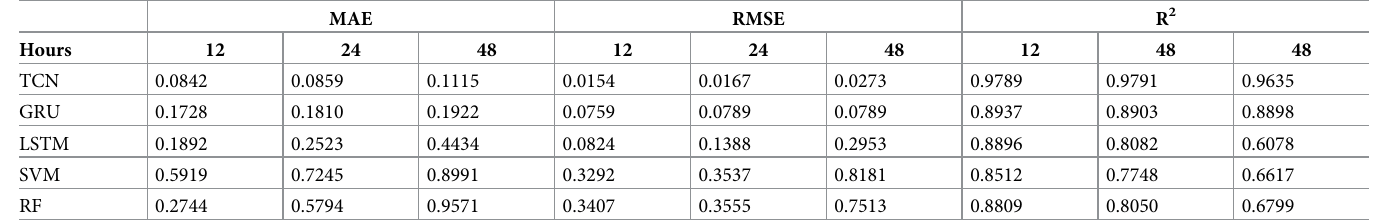
Table 3. Comparison of model